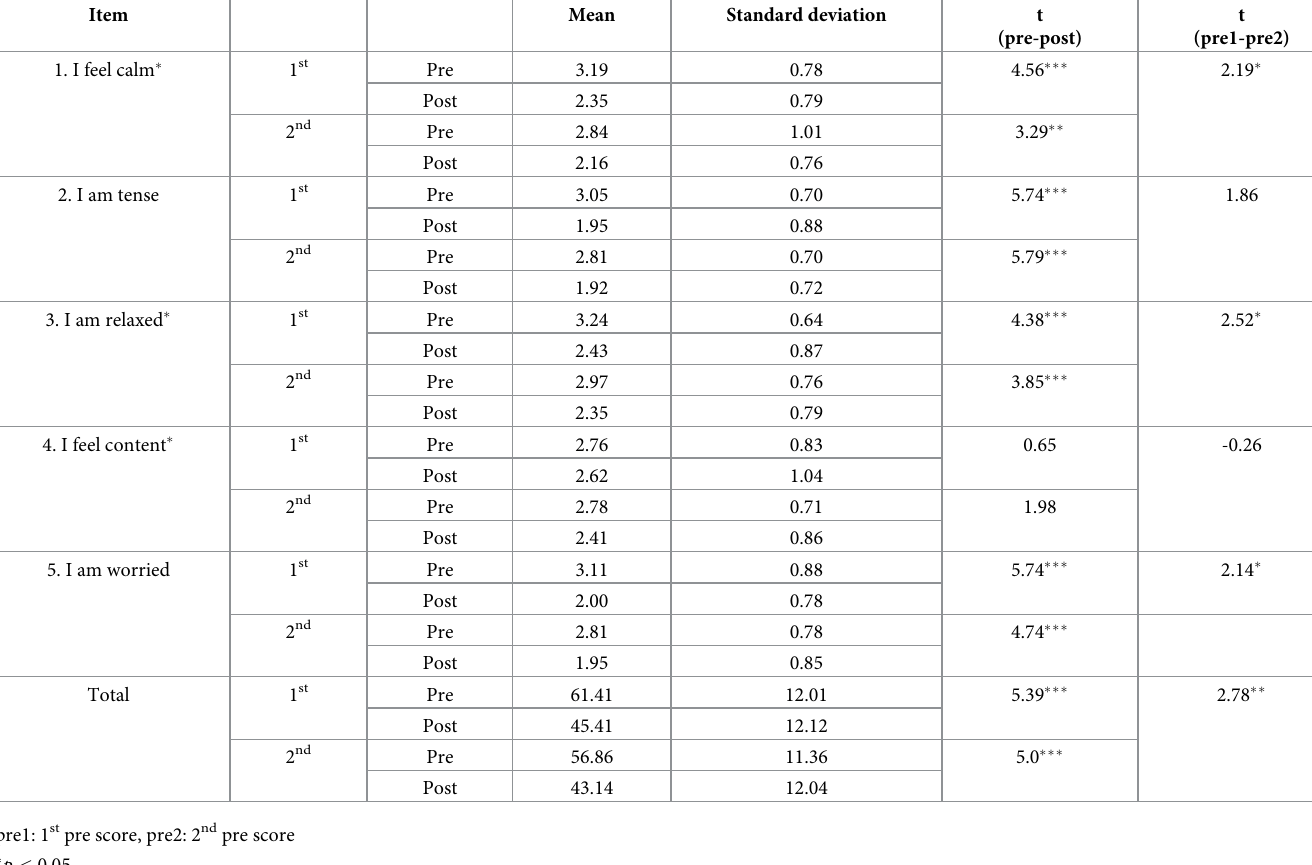
Table 1. Comparison of changes in anxiety levels according to simulation practice. Item Mean Standard deviation t